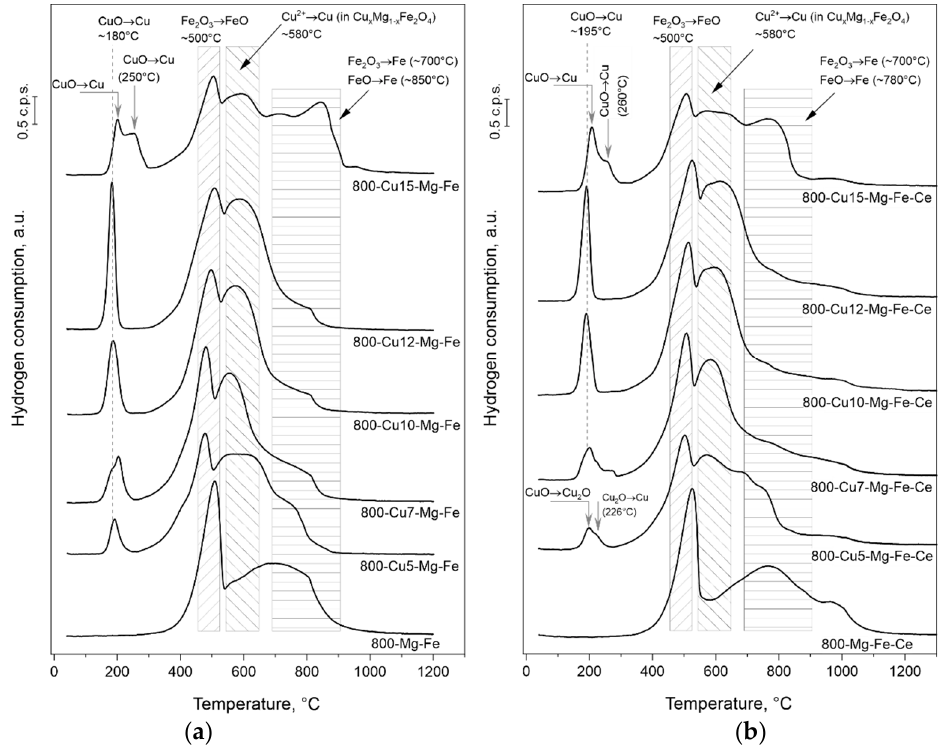
Figure 4. H 2 -TPR profiles of obtained catalysts ( a ) Cu-Mg-Fe-O and ( b ) Cu-Mg-Fe-O-Ce.